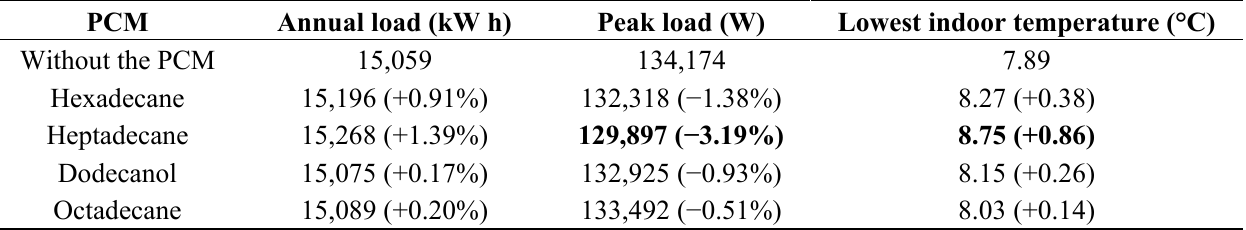
Table 4. Indoor thermal characteristics of the heating